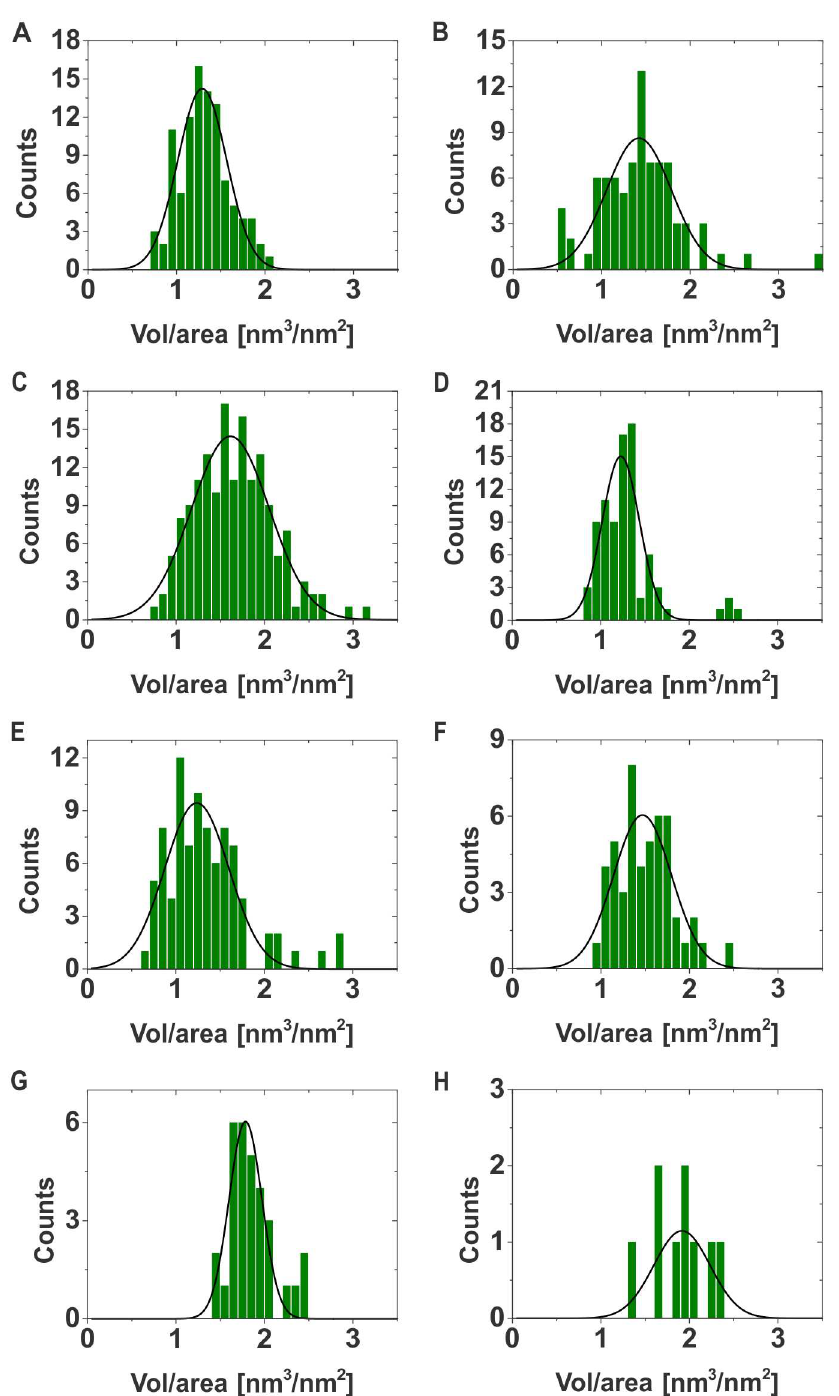
Fig 2. Salt-dependent chromatin arraycompaction. Shownare histograms (green) of chromatinarray compaction, i.e. volume/area. The arrays were imagedby AFM and analysedusing a graph cut algorithmto extract the volume and area occupiedby each array. Plotted is the volume over area ratio. In black the Gaussianfits for each histogramare presented. A: 0 mM NaCl, B: 20 mM NaCl, C: 30 mM NaCl, D: 50 mM NaCl, E: 75 mM NaCl, F: 110 mM NaCl, G: 250 mM NaCl, H: 500 mM NaCl.